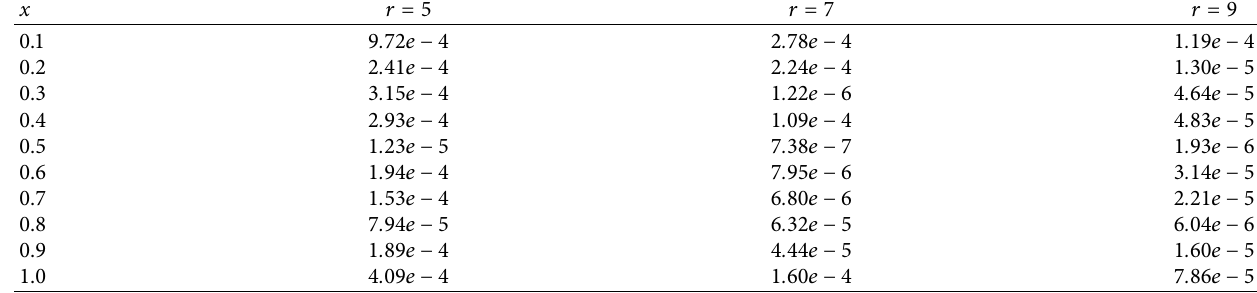
Table 1: The absolute errors at the Legendre nodes for Example 1.